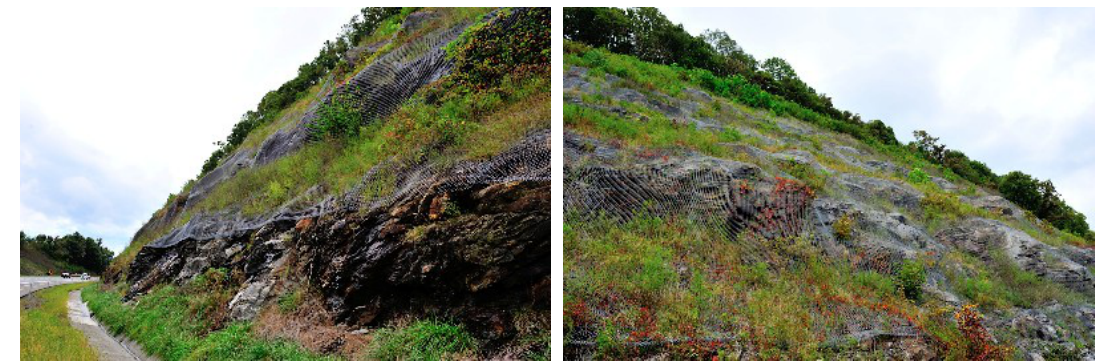
Figure 15. Two examples of the changes in time series around June 2016 for points on the slope in small area B. One possible explanation is the steel mesh installation during that time period at this location that covered the rock on Interstate 77. The barrier would help prevent loose rocks or boulders from falling onto the roadway. Meanwhile, the installation could as well alter the signals received by